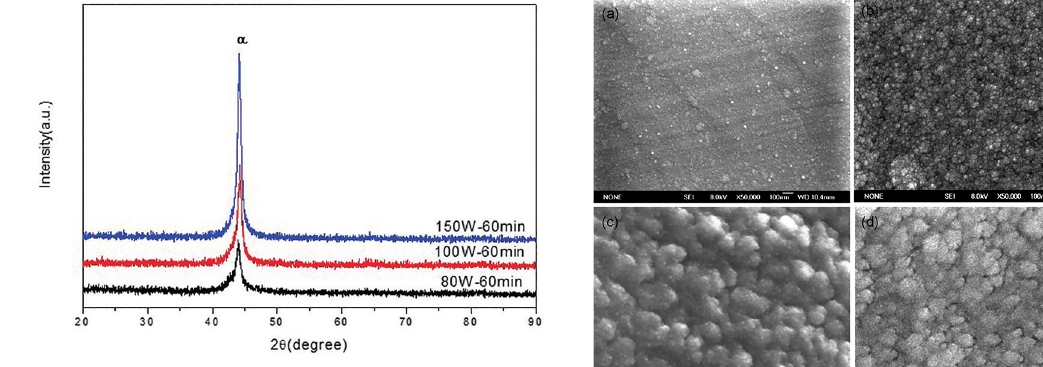
Figure 3: X-Ray diffraction curves of the coatings under different plasma power at 60 minutes.